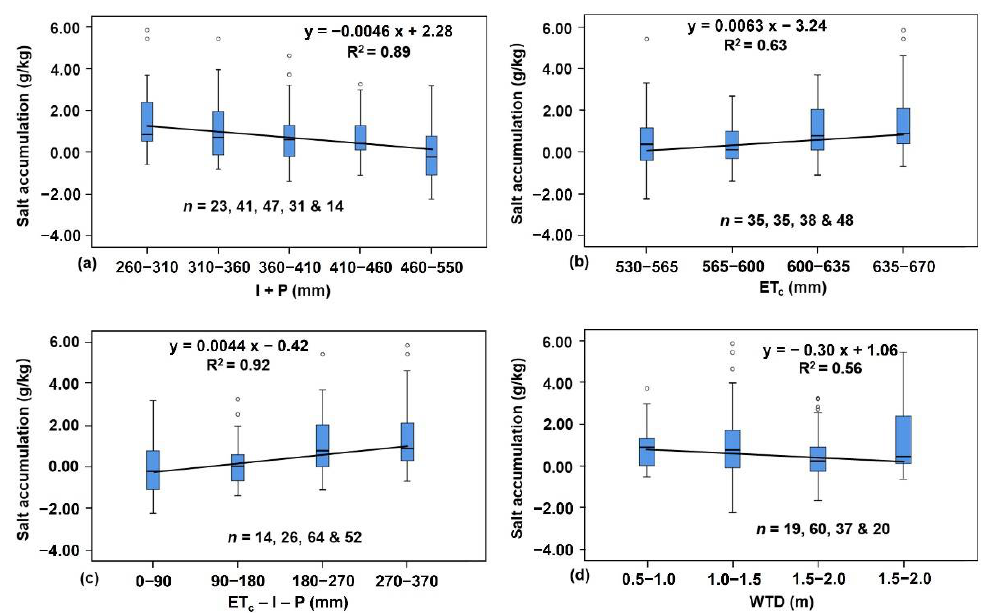
Figure 9. The relationship between the cropping season salt accumulation (g/kg) and the cropping season water input (I + P, a ), potential crop evapotranspiration (ET c , b ), water deficit (ET c − I − P, c ), and average water table depth (WTD, d